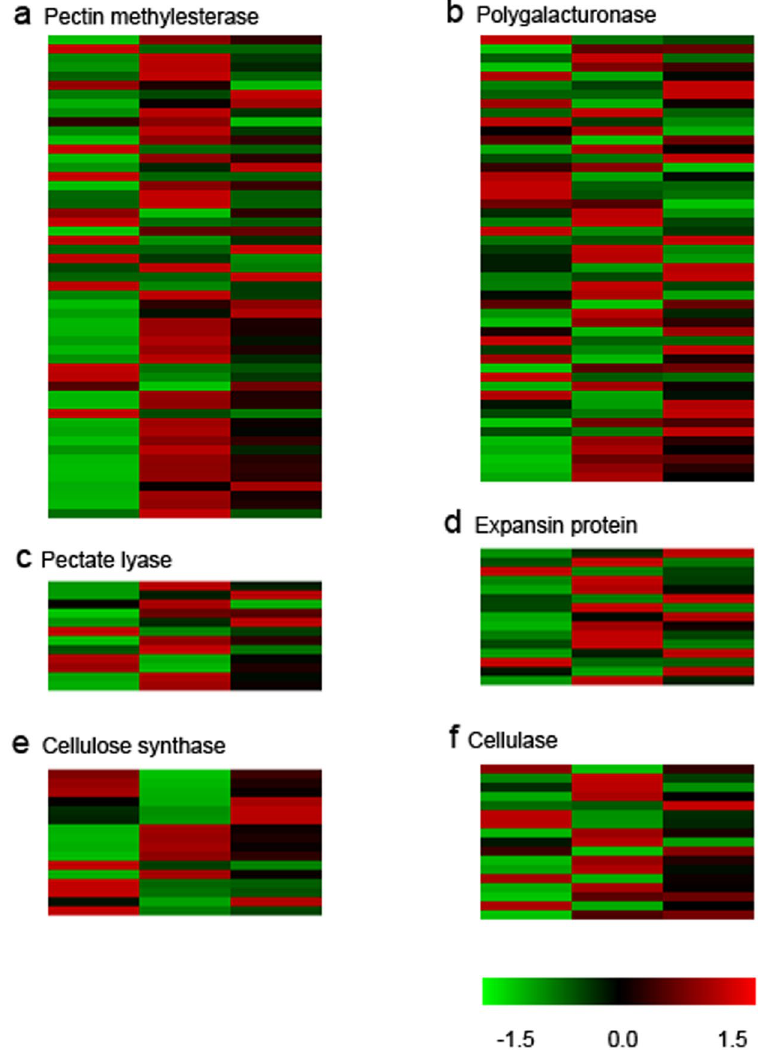
Figure 5. Heat map of cell-wall related genes expression. ( a ) Genes encoding pectin methylesterase, ( b ) genes encoding polygalacturonase, ( c ) genes encoding pectate lyase, ( d ) genes encoding expansin protein, ( e ) genes encoding cellulose synthase, ( f ) genes encoding